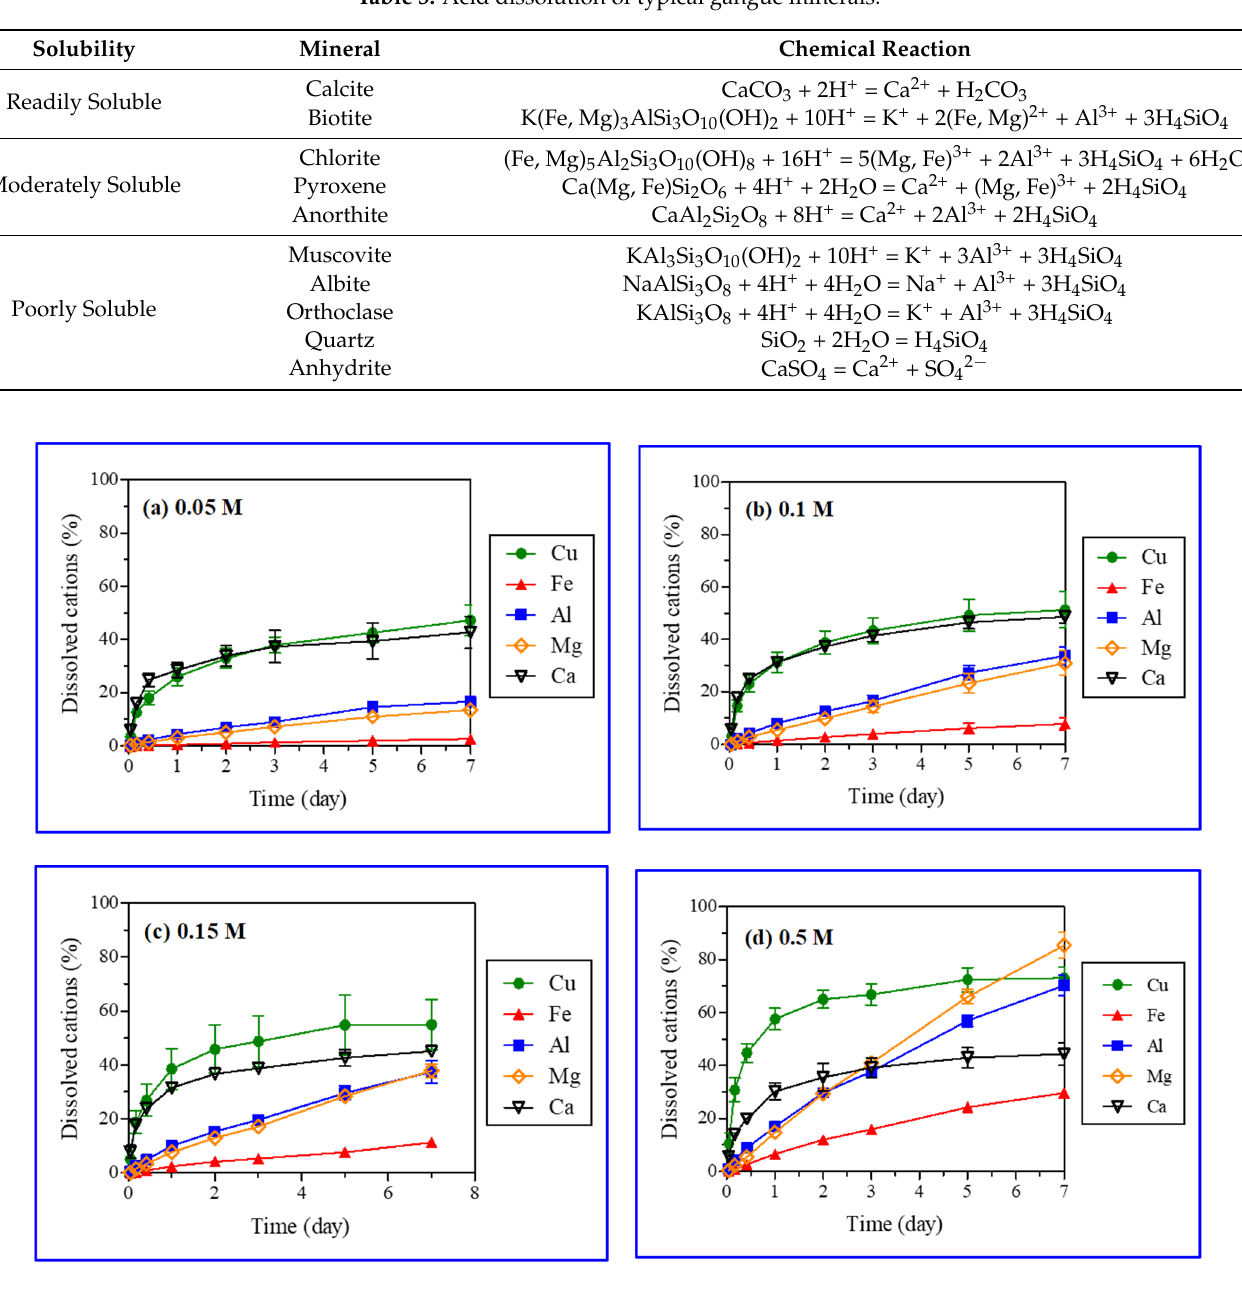
Figure 7. Leaching kinetics of metals with selected ore particle size (5.6–11.2 mm) and sulfuric acid (H 2 SO 4 ) concentrations (0.05 M ( a ), 0.1 M ( b ), 0.15 M ( c ), and 0.5 M ( d )).